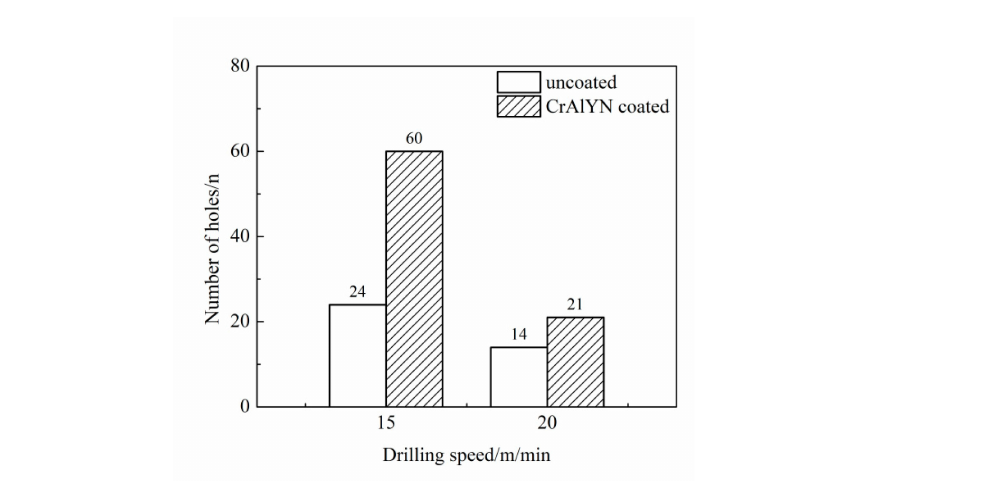
Figure 4. Service life of coated and uncoated drills (drilling depth of 6 mm and drilling feed rate of 0.04